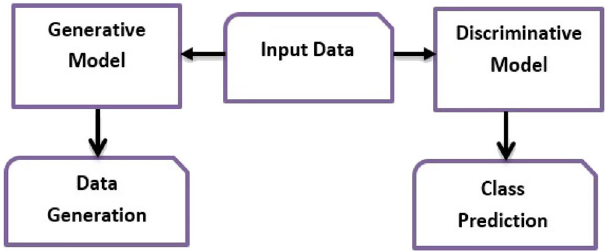
Figure 2. Difference between generative and discriminative modeling in dealing with input data.